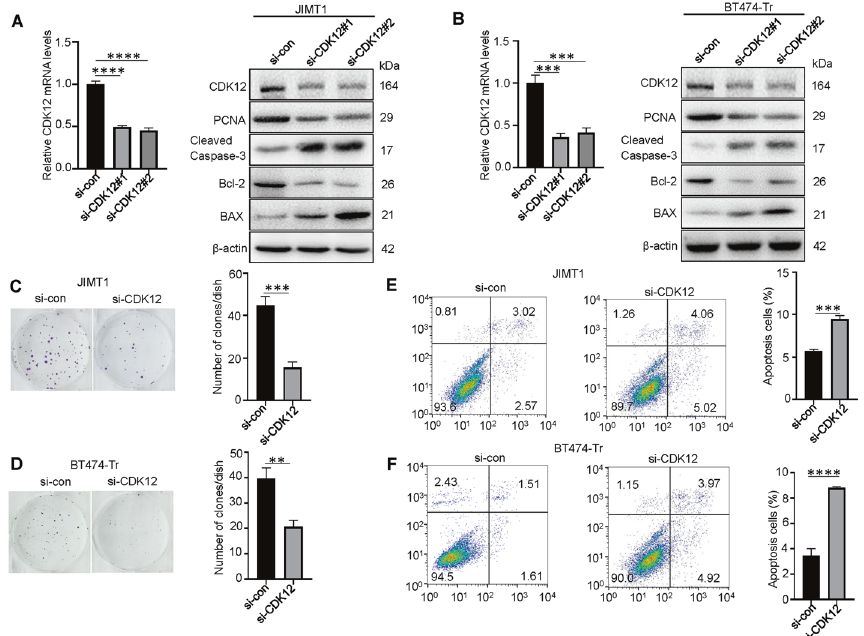
Fig. 5 CDK12 is involved in the promotion of proliferation and inhibition of apoptosis in trastuzumab-resistant breast cancer. A , B qRT – PCR results showing levels of CDK12 expression in JIMT1 and BT474-Tr cells transfected with CDK12 siRNAs, respectively. Protein levels of PCNA, Cleaved Caspase-3, Bcl-2, BAX in JIMT1 and BT474-Tr cells transfected with CDK12 siRNAs. β -actin served as the internal control. C , D Interference with CDK12 siRNAs in JIMT1 and BT474-Tr cells impacted cell proliferation as determined by colony formation assays.